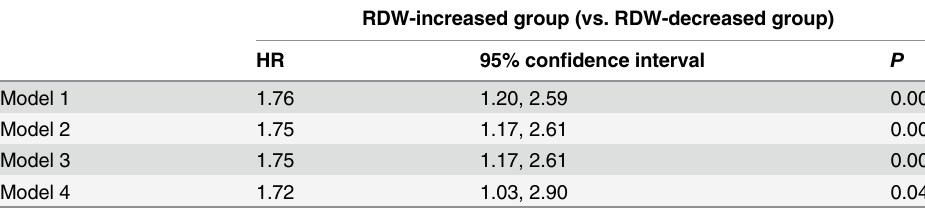
Table 4. Cox proportional hazard analysis for nonfatal CV events and